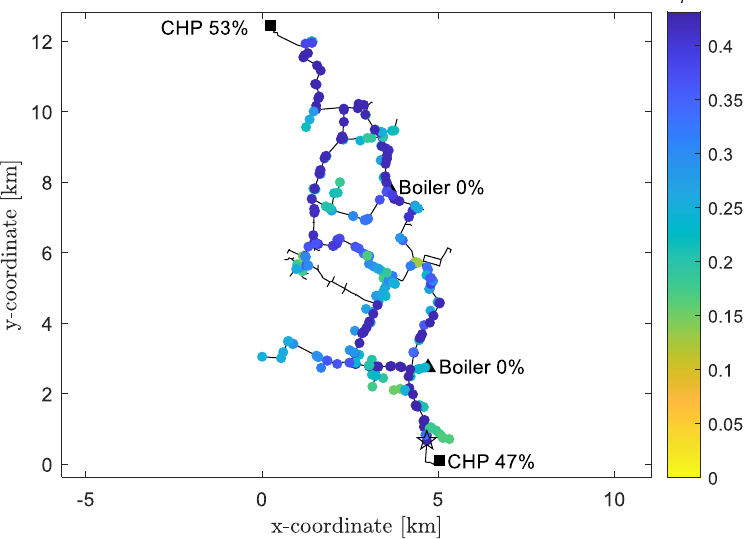
Figure 6. φ coefficient throughout the analyzed DH network in a cogeneration-based operation (the star indicates the best position) − Configuration 1, base case.